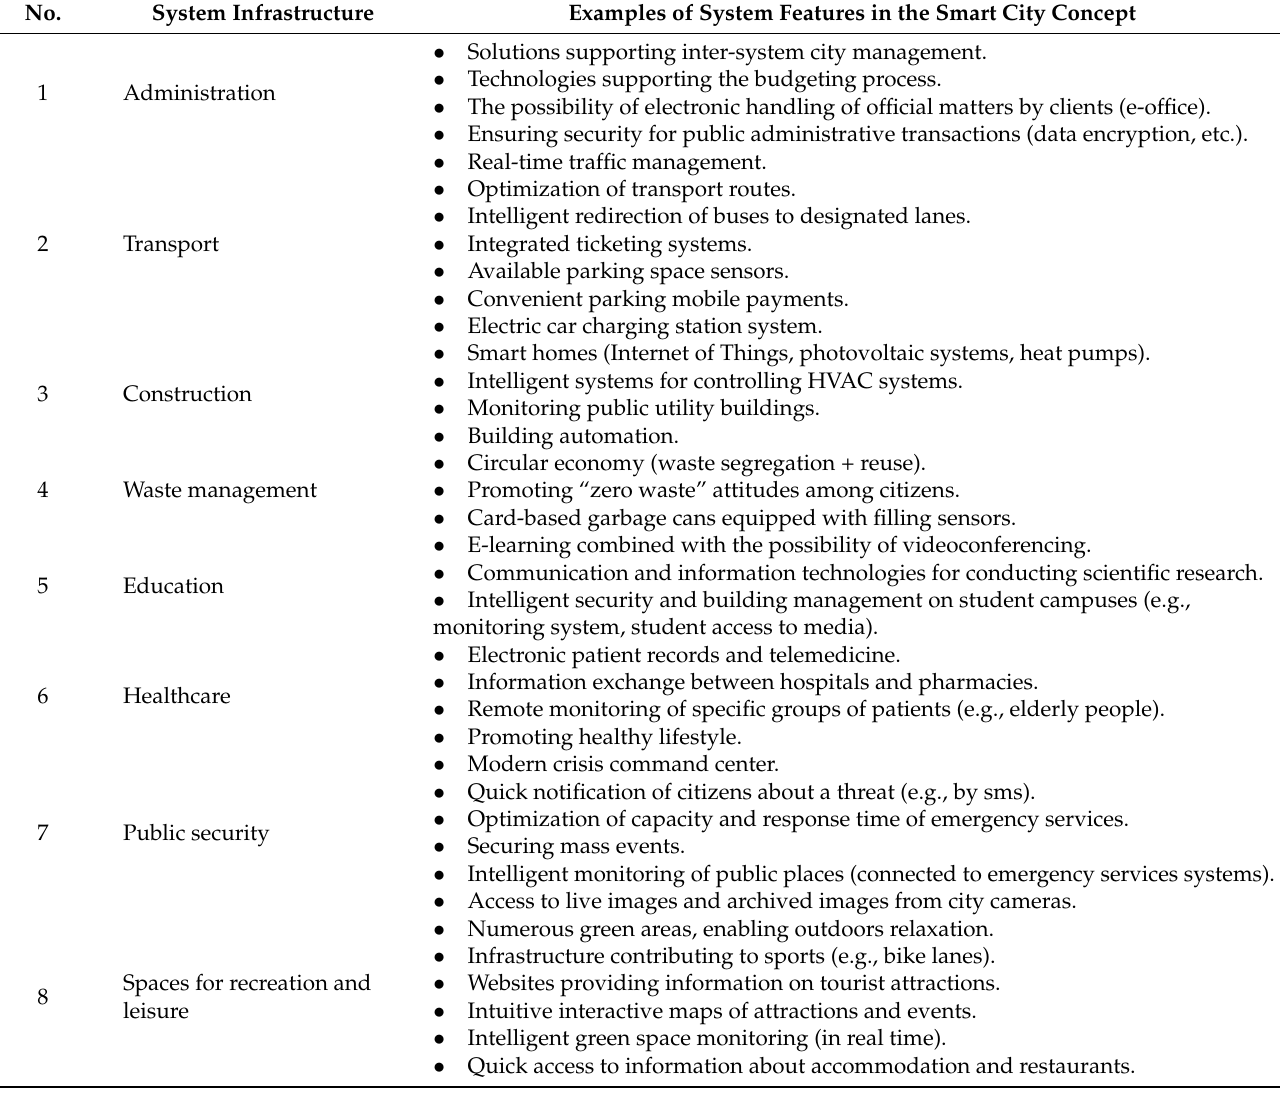
Table 2. Basic infrastructure systems in a smart city according to B é lissent [12]; Zuccal à and Verga [13]. No. System Infrastructure Examples of System Features in the Smart City